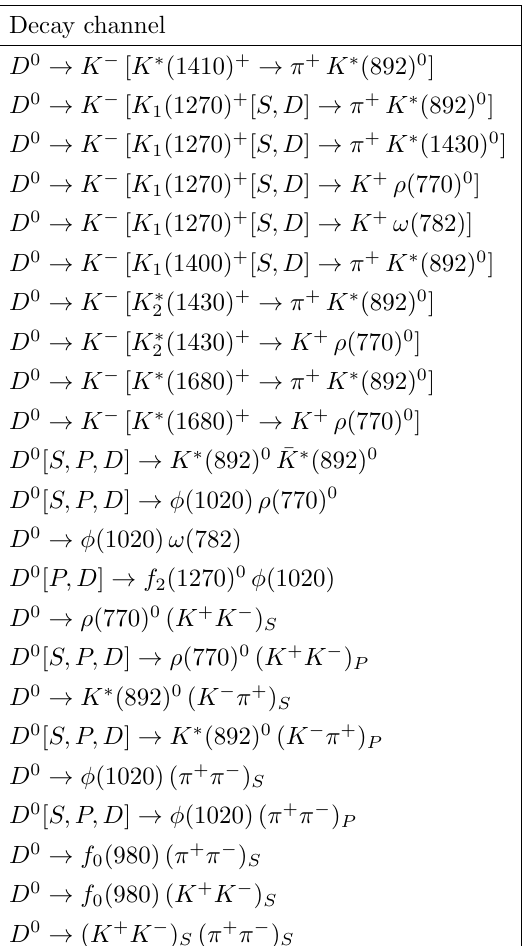
Table 17 . Decays considered in D 0 ! K + K (cid:0) (cid:25) + (cid:25) (cid:0) LASSO model building. For cascade non-self- conjugate channels, the conjugate partner is implied.